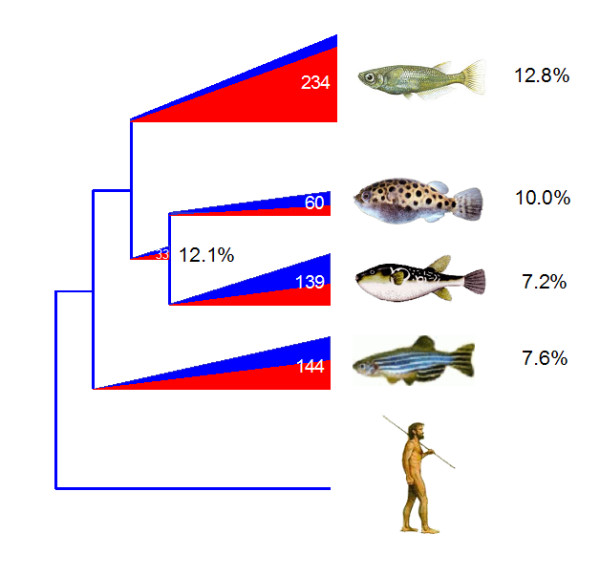
Phylogeny of the studied fish species. The proportion of genes with significantly lower (red) or higher (blue) distance to the human ortholog than to other fish species, are mapped onto the phylogeny as proportional triangles. Numbers within the triangle represent the total abundance of those genes. The percentages represent the corresponding proportion of transcription factors.